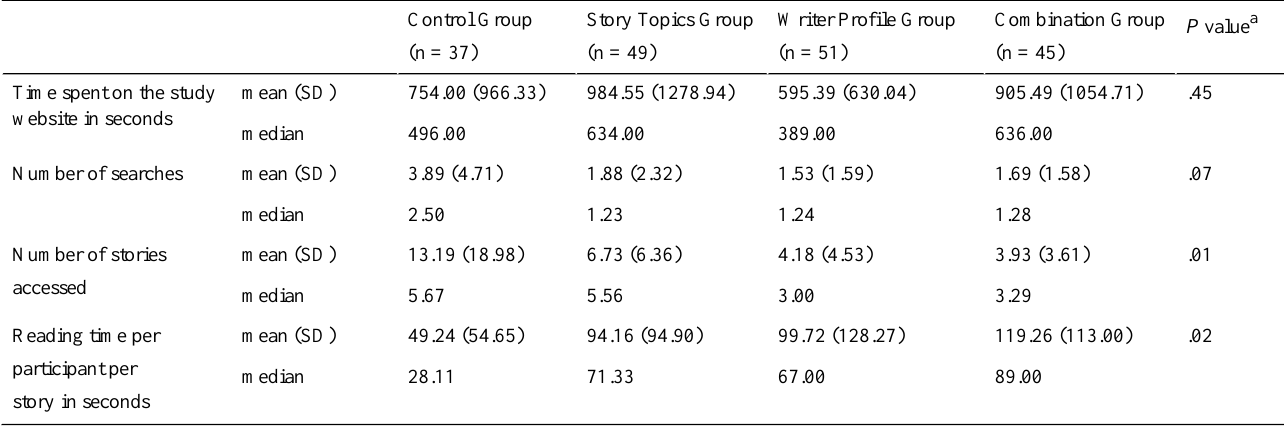
Table 4. Comparison of the four groups for the search behaviour measures recorded by the log data